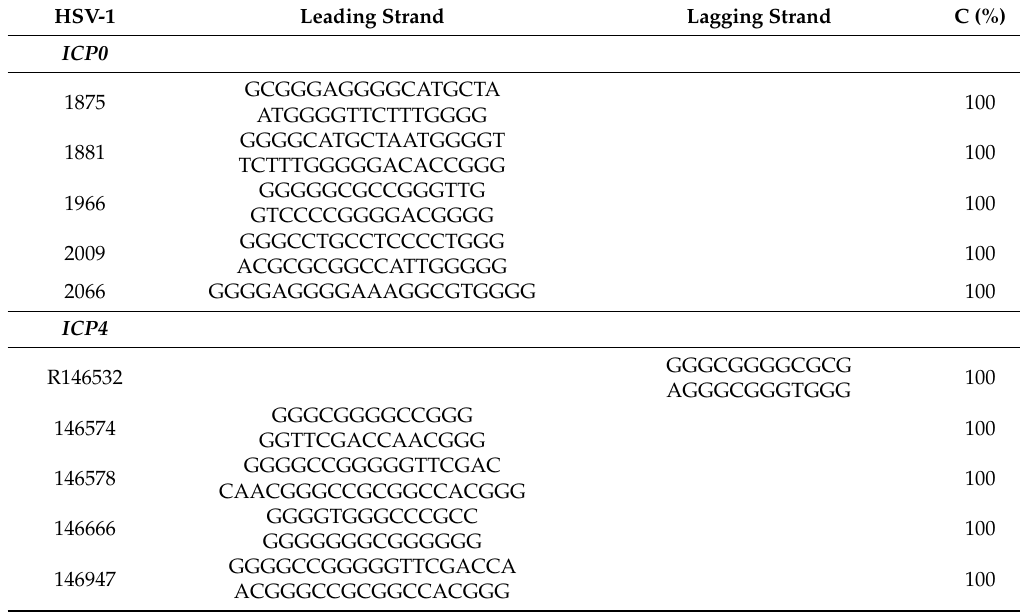
Table 1. Putative Quadruplex Sequences (PQS) in the Herpes Simplex Virus 1 (HSV-1) Immediate Early (IE) promoter sequences. Each PQS is indicated by the 5 (cid:48) nucleotide (nt) position on the viral reference genome (NC_001806.2). The leading and the lagging strands are indicated with respect to the Transcription Start Site (TSS) position. The conservation ratio (C (%)) of the entire sequence (G tracts and loops) among all the strains available in the National Center for Biotechnology Information (NCBI) databank is also